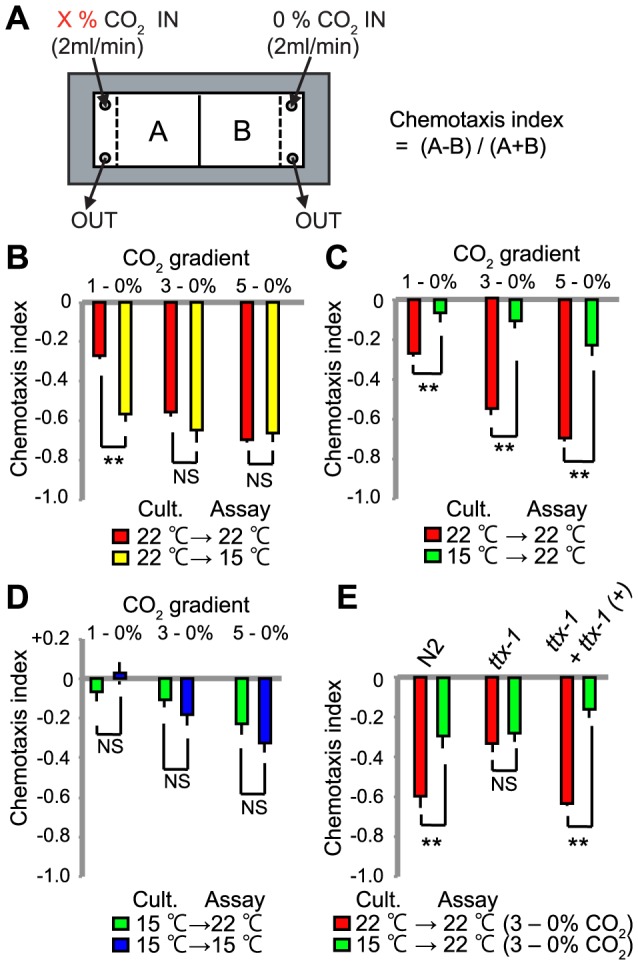
CO2 avoidance is modulated by acclimation temperature.A. Assay for C. elegans CO2 responses. Animals navigate a defined CO2 gradient in a microfluidic device. The chemotaxis index is calculated by counting animals in two halves of the device, using the formula shown. B–D. Chemotaxis indices for animals cultivated at either 15°C or 22°C and assayed in different CO2 gradients at either 15°C or 22°C. **, p<0.01; n.s., not significant, Student's t-test. E. A mutation in ttx-1, which is specifically required to confer AFD neural identity, disrupts modulation of CO2 avoidance by acclimation temperature. Assays were performed in 3%–0% CO2 gradients. **, p<0.01; n.s., not significant, Student's t-test.